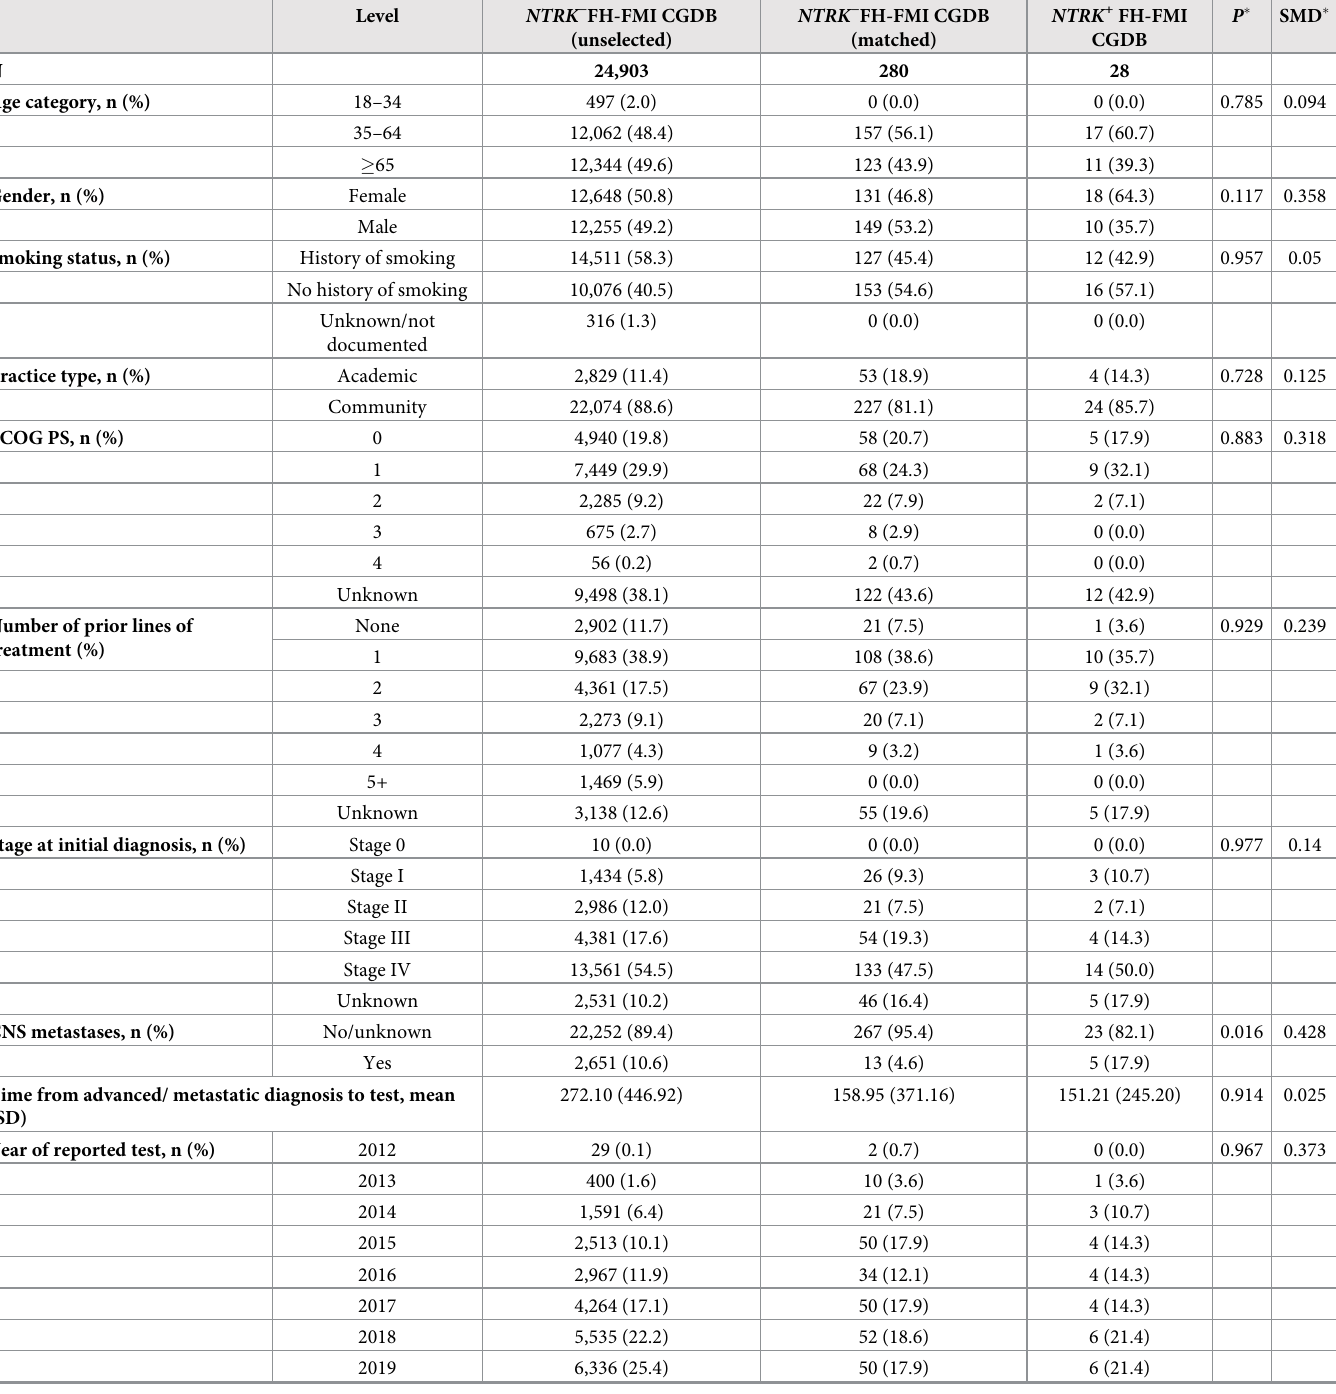
Table 2. Comparison of patient characteristics for the unselected NTRK – , matched NTRK − and NTRK +